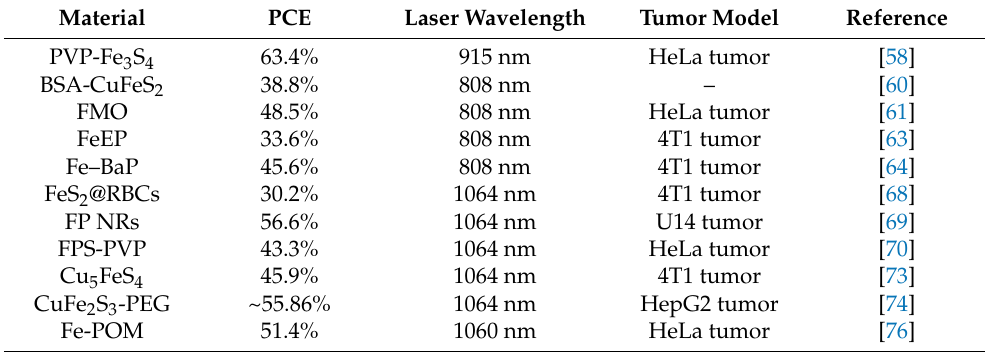
Table 1. Summary of different Fe-based nanoagents for cancer therapy.